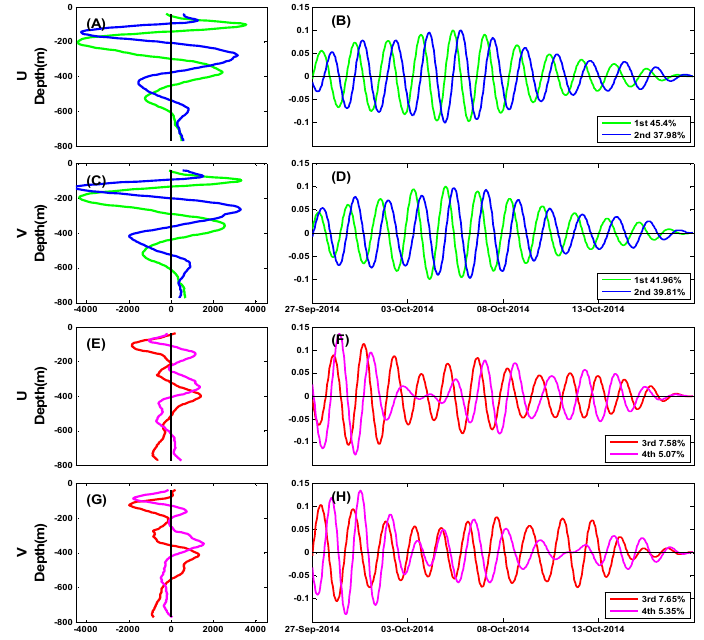
Figure 8. Vertical profiles of the ( A and E ) eastward and ( C and G ) northward components of the near-inertial current and the corresponding ( B and F ) eastward and ( D and H ) northward time series by empirical orthogonal function (EOF) analysis. The first and second modes are shown in A , B , C , and D . Meanwhile, the third and fourth modes are shown in E , F , G , and H . The NIO event occurred in September 2014.